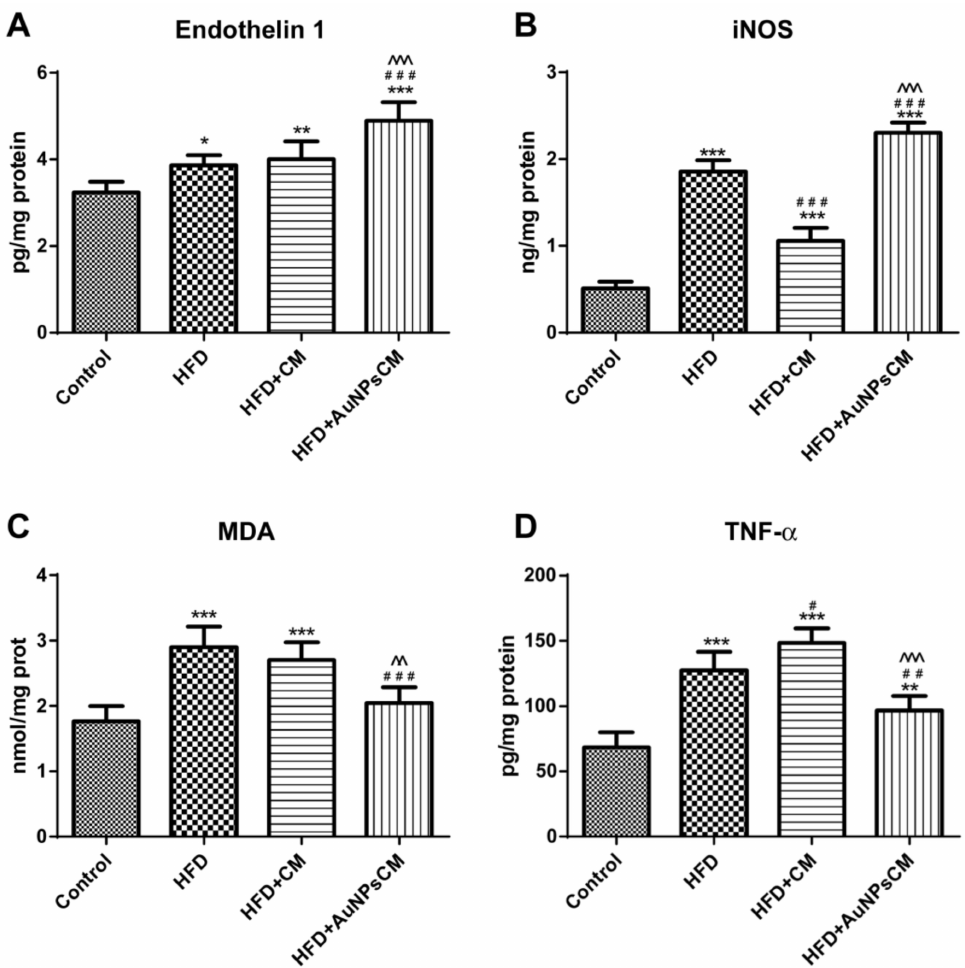
Figure 9. The aorta parameters after 9 months of HFD, the last month with oral administration of: 0.9% saline solution for Control and HFD groups, Cornus mas L. extract for HFD + CM group and gold nanoparticles functionalized with bioactive compounds from Cornus mas L. extract for HFD + AuNPsCM group: endothelin 1 ( A ), iNOS ( B ), MDA ( C ) and TNF-alpha ( D ) (* compared to Control group, # compared to HFD group; ˆ compared to HFD + CM group). The results were statistically analyzed by one-way ANOVA followed by the Post-test Tukey, using GraphPad Prism version 5.03 software (GraphPad, SanDiego, USA). The parameters were expressed as means ± SD (* p < 0.05, ** p < 0.01, *** p < 0.001 compared to Control group; ## p < 0.01, ### p < 0.001 compared to HFD group; ˆˆ p < 0.01, ˆˆˆ p < 0.001 compared to HFD + CM